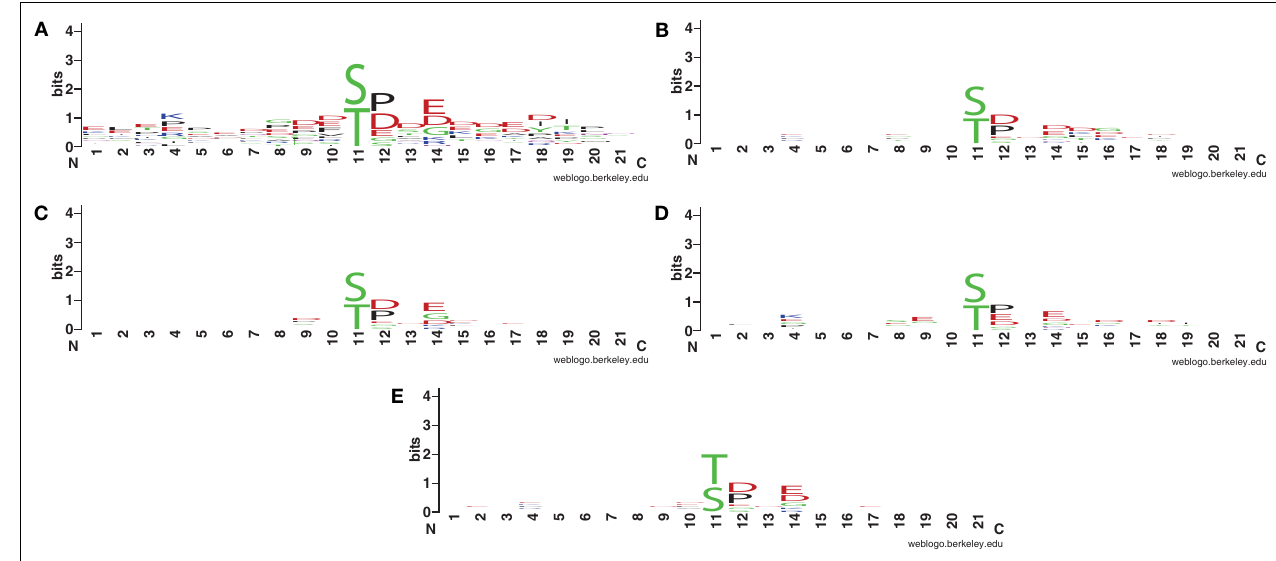
FIGURE 5 |WebLogo for S/T centered, conserved phosphorylation sites without gap in the sequence alignment: (A) overall plot for all S/T aligned sequences without gaps, (B) A. thaliana , (C) O. sativa , (D) R. communis , and (E) P. patens .